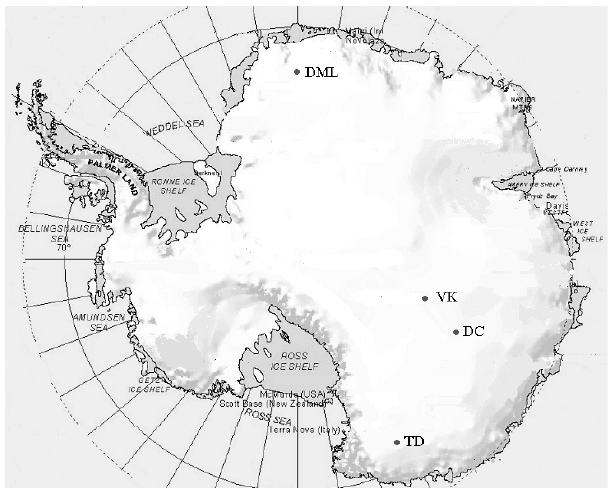
Fig. 1. Map showing the drilling site of Talos Dome (TD) together with other ice core drilling sites (DC: Dome C, VK: Vostok; DML: Dronning Maud Land).